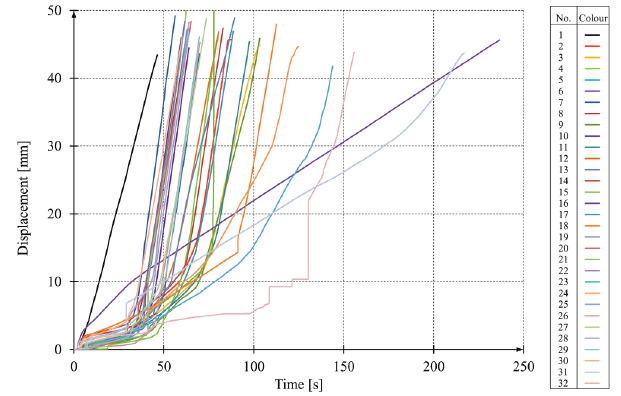
Fig. 20a. Slip on load application plane in masonry specimens